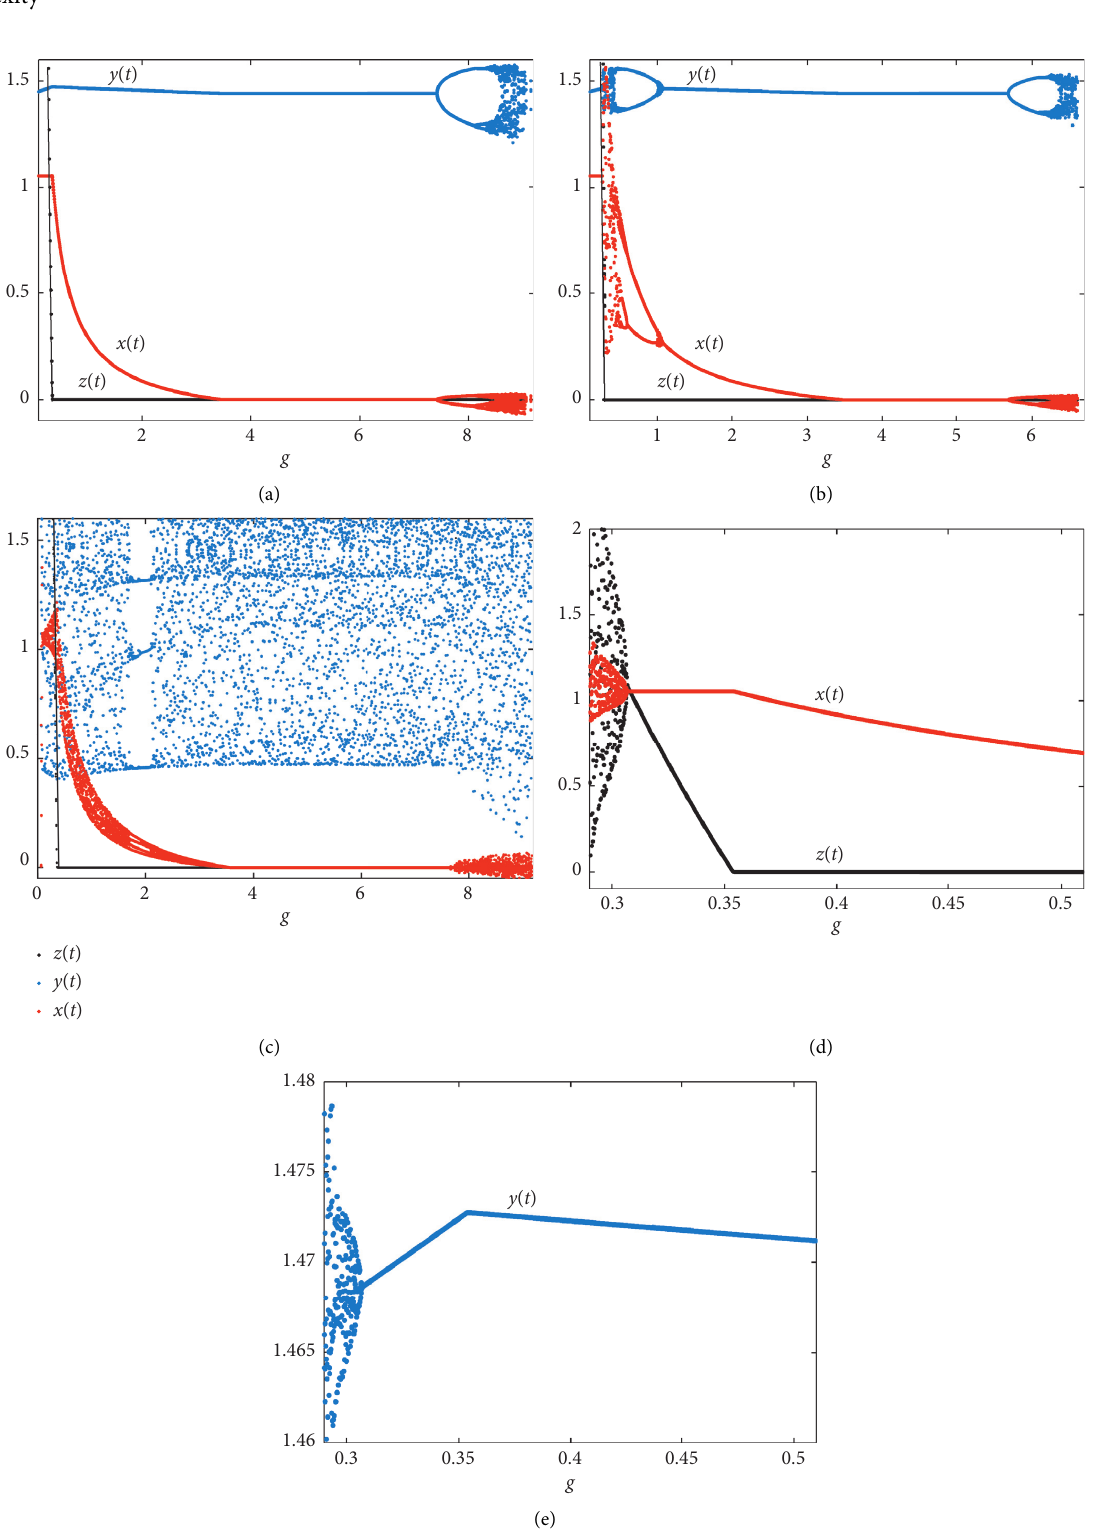
� 0 . 7 , α � 0 . 21 , and α 1 2 � 10 ( x ( t ), z ( t )); (e) α 3